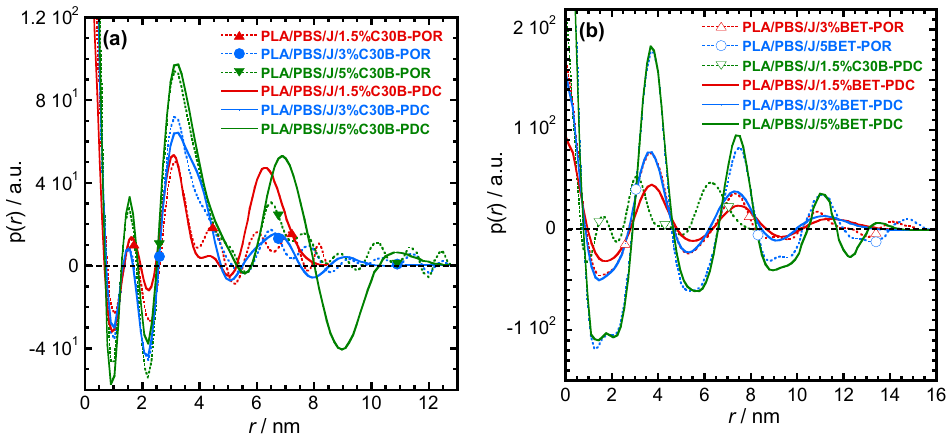
Figure 8. The pair-distance-distribution functions [p(r)] for ( a ) PLA/PBS/J/C30B and ( b ) PLA/PBS/J/BET for different clay loadings. “POR” denotes p(r) determined using the GIFT technique. The deconvolution of the approximate electron density distribution function provides a p(r) function, as denoted by “PDC”. BET is Betsopa™, C30B is Cloisite ® 30B, and J is Joncryl.